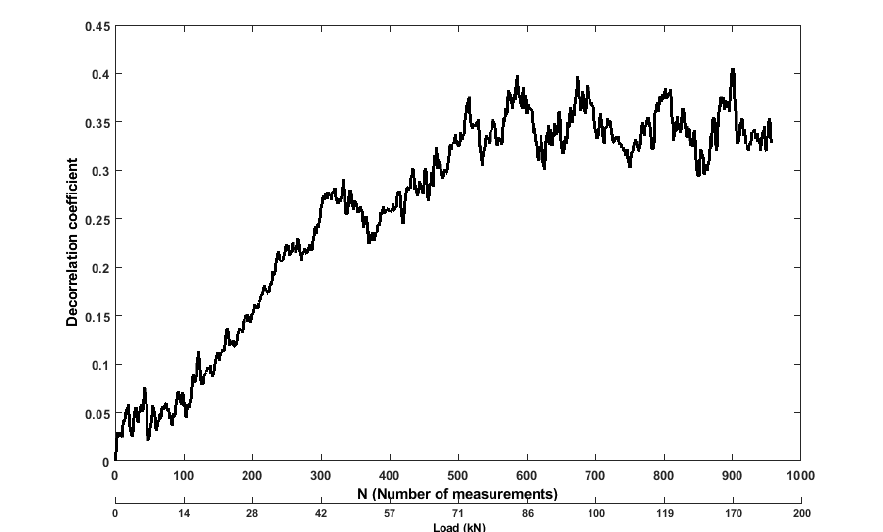
Figure 13. Values of decorrelation coefficient feature from ultrasonic pair S01R04 time